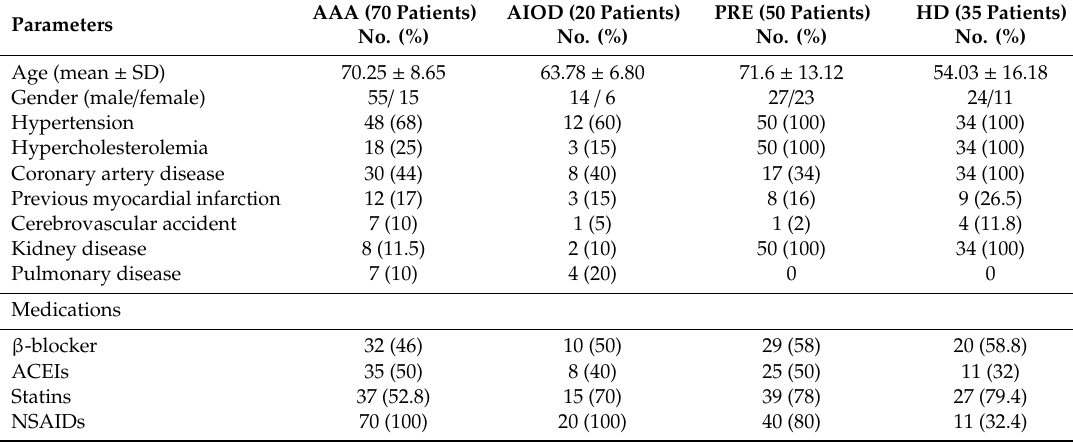
Table 1. Clinical characteristics of the analyzed groups of patients with AAA, AIOD, PRE, and HD.